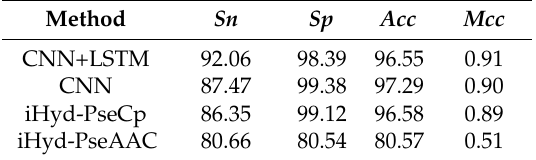
Table 5. A comparison of predictors for identifying hydroxyproline sites on Dataset 5.